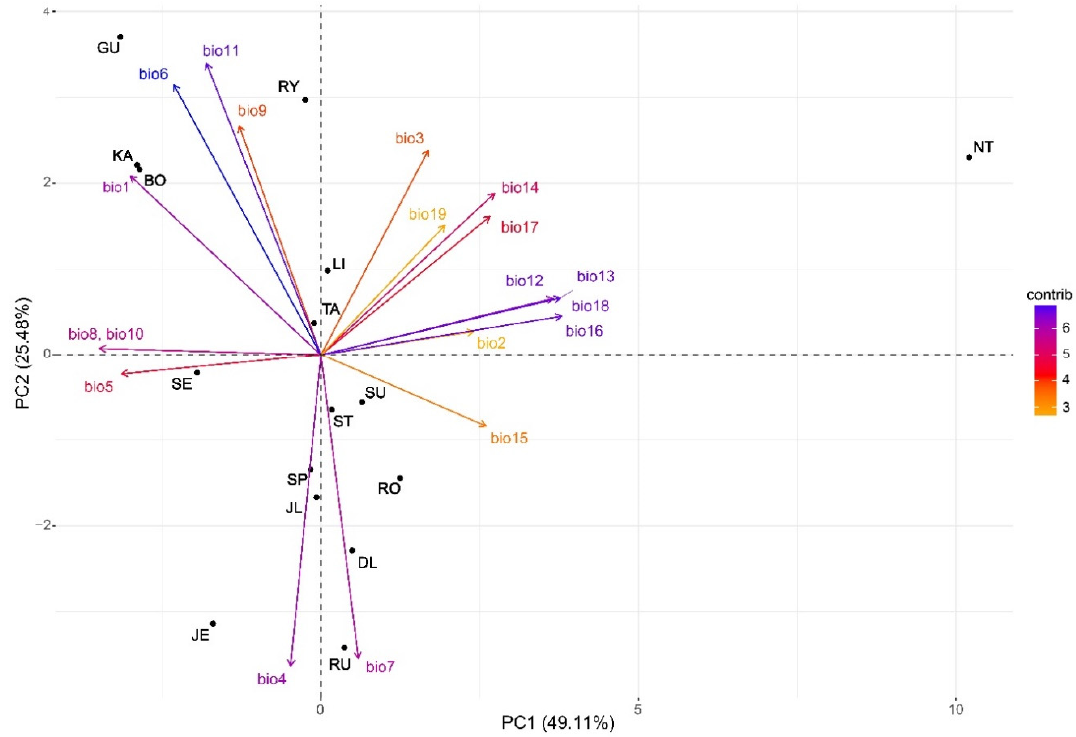
Figure 7. Climate–related variability between provenances and the trial site based on bioclimatic indexes. Explanations: SE: S ę kocin trial site; BO, DL, GU, JE, JL, KA, LI, NT, RO, RU, RY, SP, ST, SU and TA: Scots pine provenances. Variable vectors are colored according to their contribution to total variance: orange—low, blue—high.